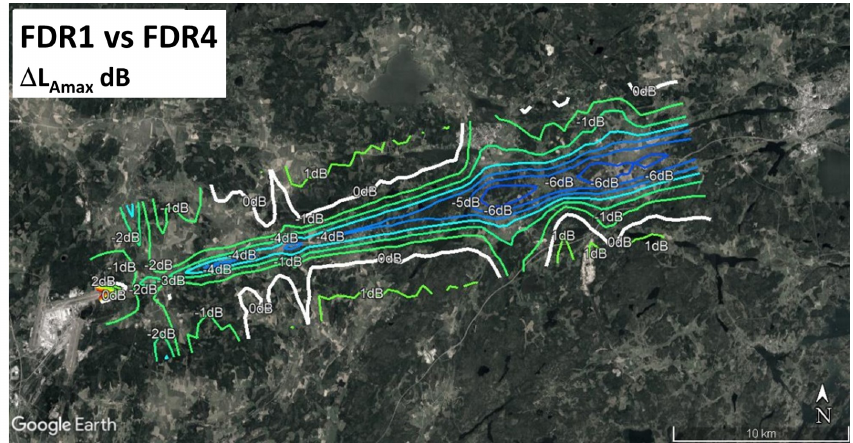
Figure 14. Noise prediction difference of FDR1 with respect to FDR4 using SAFT ECAC Doc 29 implementation.